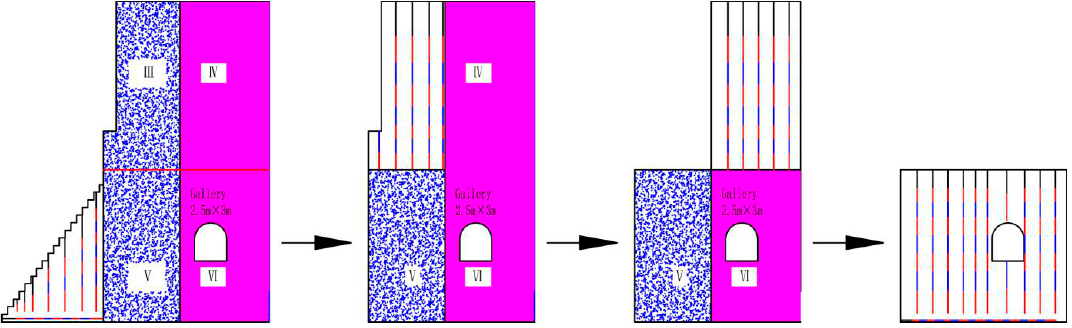
Figure 4. Blasting sequence and blasting hole arrangement.